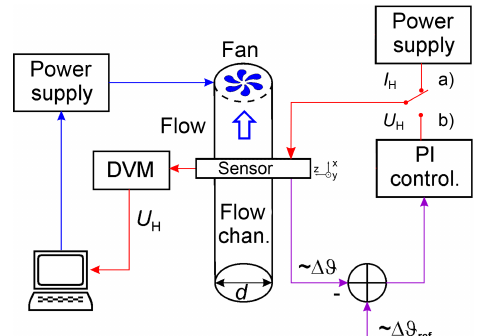
Figure 4. Sketch of the experimental set-up. The sensor was placed in the middle of the flow channel. An air flow was induced with a fan and the heater voltage has been measured with a digital voltage multimeter (DVM). The first sensor layout was supplied by a con- stant current I H (a) . For the second layout the heater voltage U H was adjusted by a common PI controller in order to keep the differ- ence between the mean temperature around the heater and the mean temperature at the sensor edges constant (cid:49)ϑ = (cid:49)ϑ ref (b) .